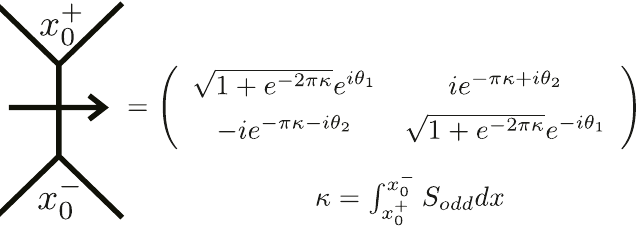
Figure 8 . Split Stokes lines of MTPs in the simple quartic potential.